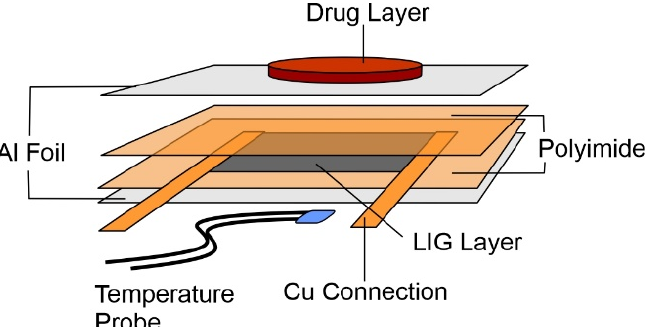
Figure 2. Schematic of the laser-induced graphene (LIG) heater components and their assembly.